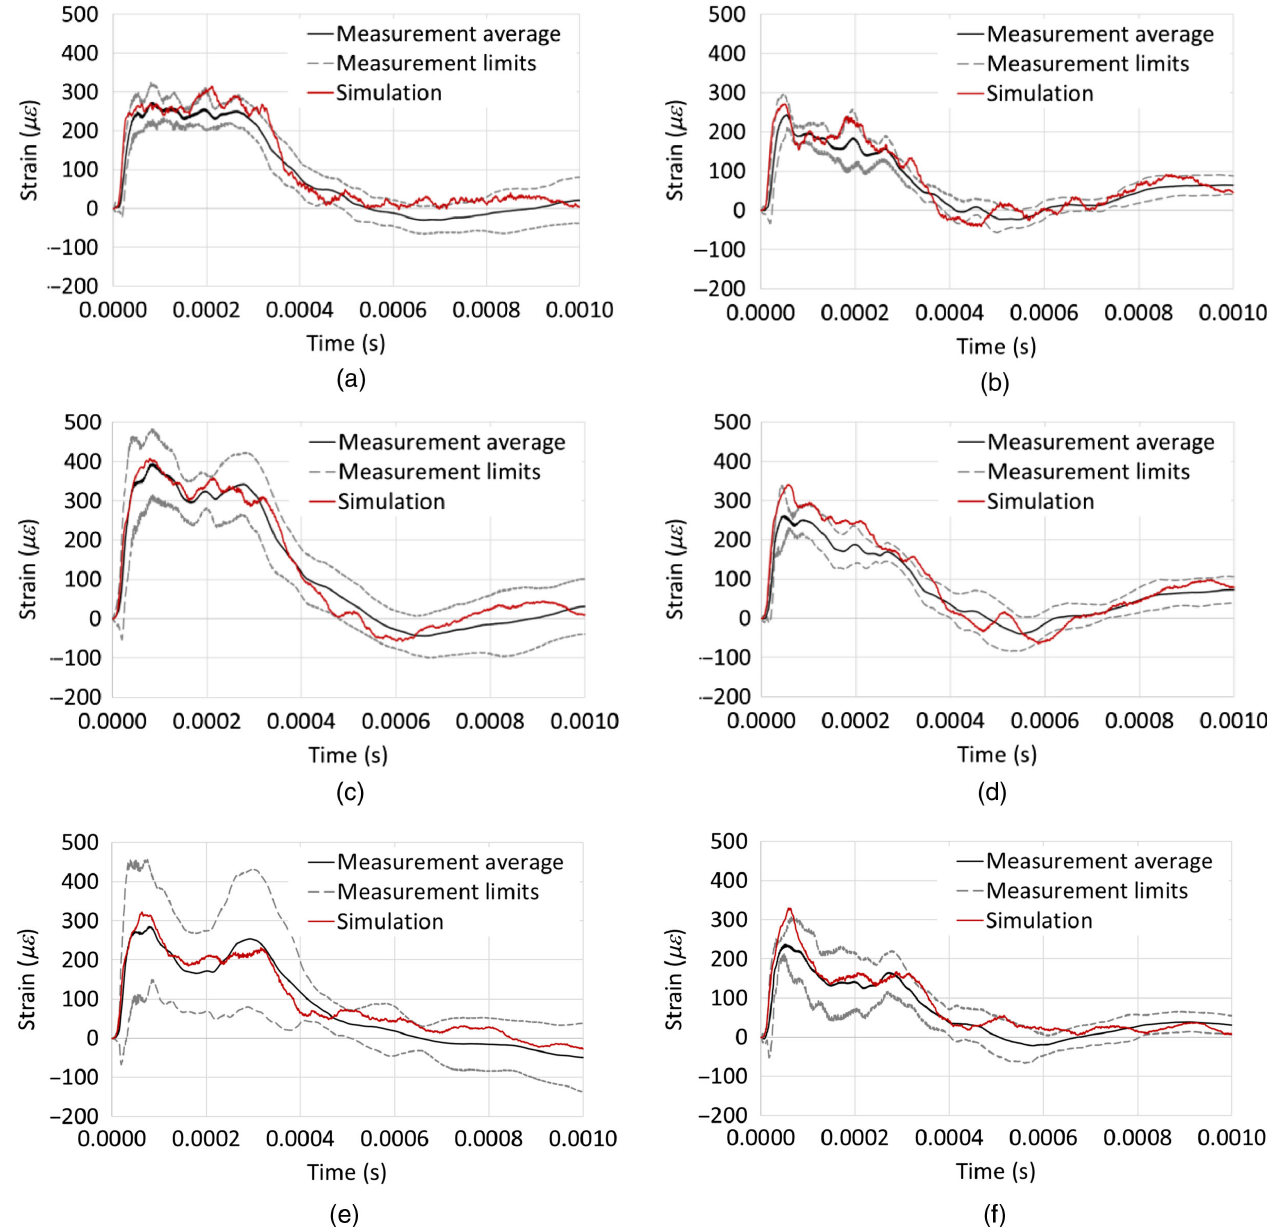
FIG. 10. Dynamic strain responses at the front center of the target in the beam direction. (a) Sensor A (center-on top). (b) Sensor M (center-on bottom) (c) Sensor T (1.8 cm from center-on top). (d) Sensor Y (1.8 cm from center-on bottom). (e) Sensor U (5.3 cm from center-on top). (f) Sensor Z (5.3 cm from center-on